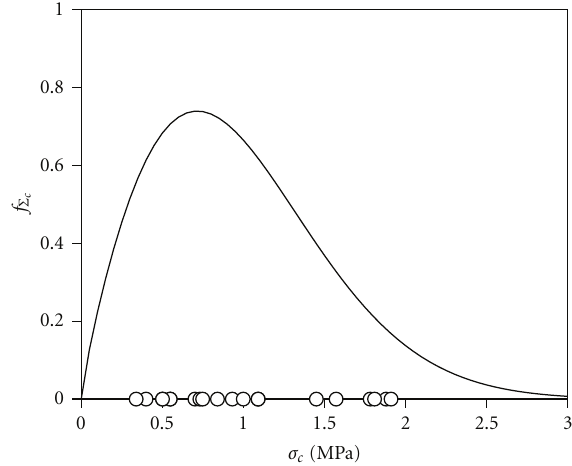
) of wall strength of c ( σ c ) c